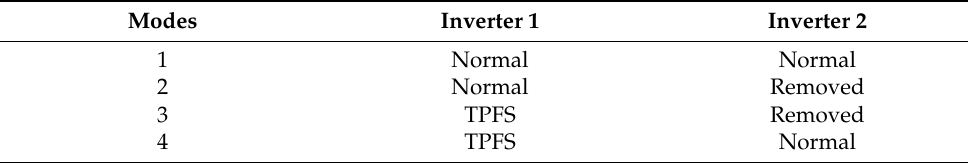
Table 1. Four operating modes.